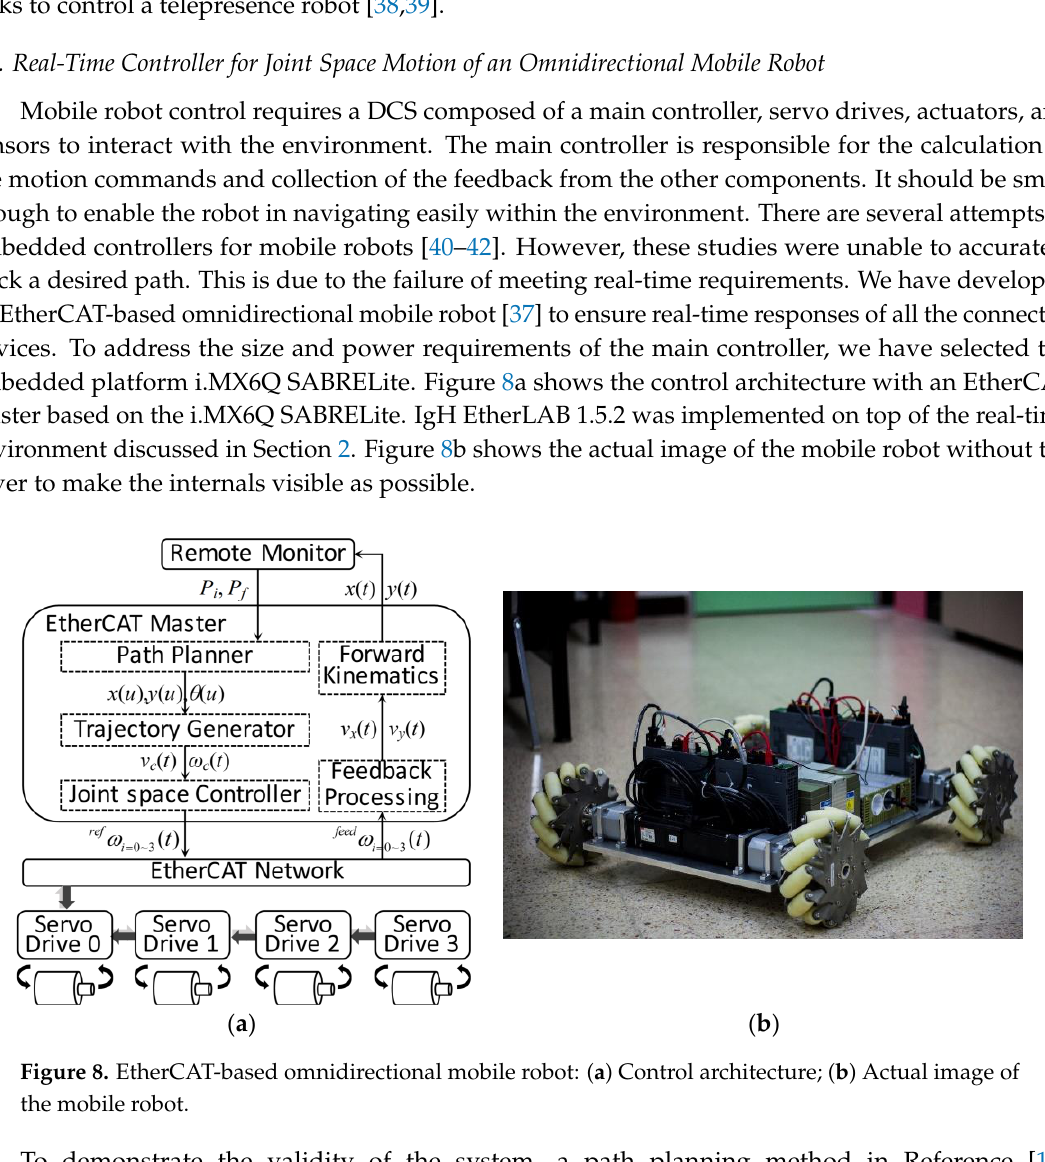
( b ) Figure 9. Navigation of the omnidirectional mobile robot: ( a ) Velocity profiles; ( b ) Trajectory. 4.2. Integration of ROS in Real-Time Control Systems